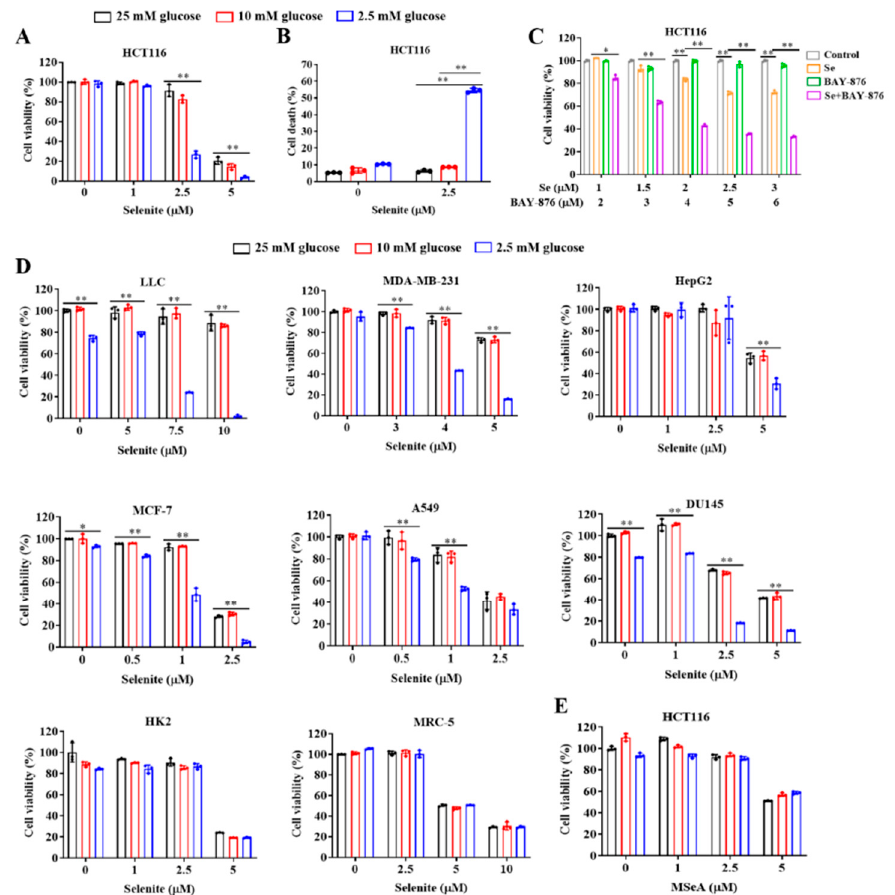
Figure 1. Glucose limitation sensitizes cancer cells to selenite-mediated cytotoxic effect. ( A , B ) Cell viability ( A ) and cell death ( B ) of HCT116 cells cultured in the medium containing indicated concentrations of glucose with or without treatment of selenite for 24 h. ( C ) Cell viability of HCT116 cells with or without treatment of selenite, BAY-876 or selenite/BAY-876 combination for 48 h. ( D ) Cell viability of LLC, A549, HepG2, MCF-7, MDA-MB-231, DU145, HK2 and MRC-5 cells cultured in the medium containing indicated concentrations of glucose with or without treatment of selenite for 24 h, 36 h, 36 h, 48h, 36 h, 48 h, 48 h and 48 h, respectively. ( E ) Cell viability of HCT116 cells cultured in the medium containing indicated concentrations of glucose with or without treatment of methylseleninic acid for 24 h. Results are representative of three biologically independent experiments. Data are expressed as mean ± SD, * p < 0.05, ** p < 0.01. Se: selenite; MSeA: methylseleninic